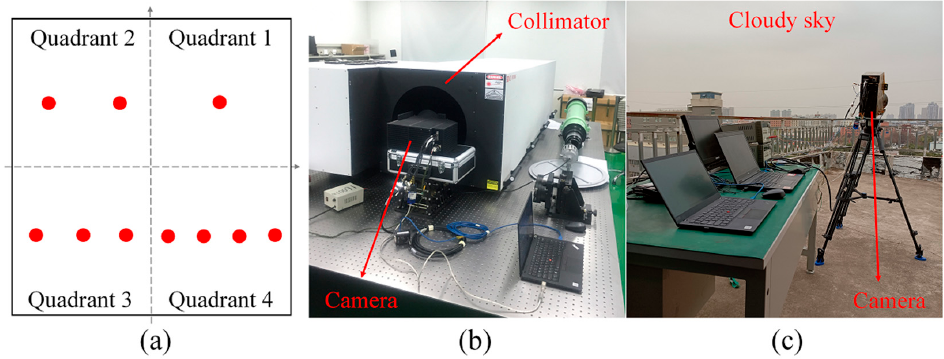
Figure 7. ( a ) Illustration of the target board, ( b ) single-pixel target acquisition, and ( c ) sequence acquisition with cloudy weather.